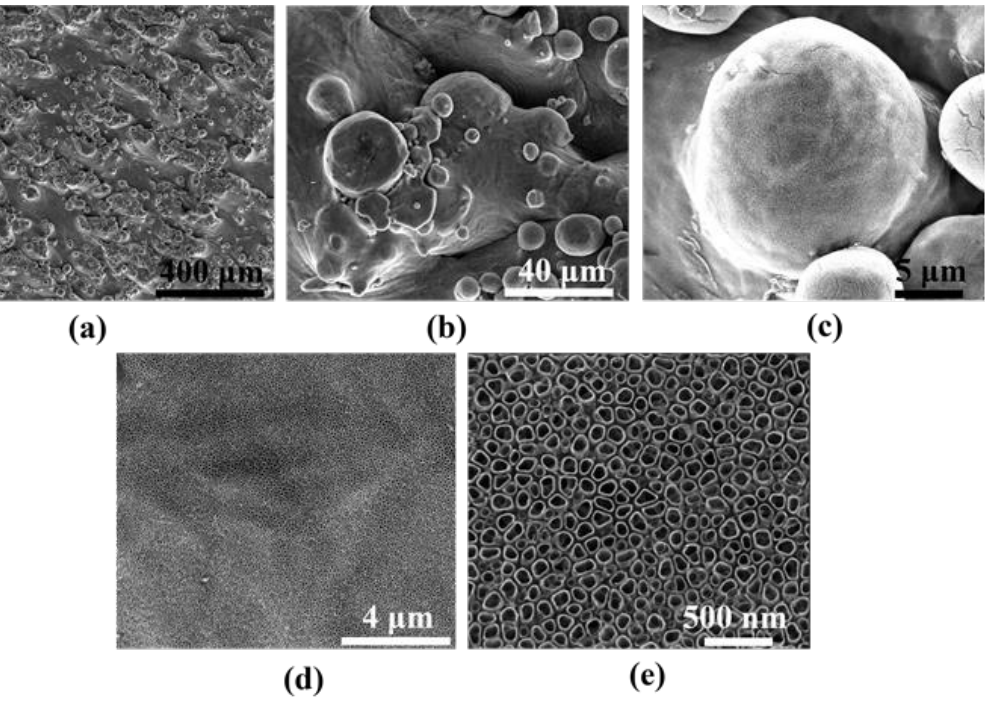
Figure 3. SEM images of Ti 3D surface after anodic oxidation in an electrolyte based on glycerin and water with ammonium fluoride and heating at 450 ° C (low and high magnification). Magnification of images is: ( a ) 100×, ( b ) 1000×, ( c ) 5000×, ( d ) 10,000× and ( e ) 50,000×.